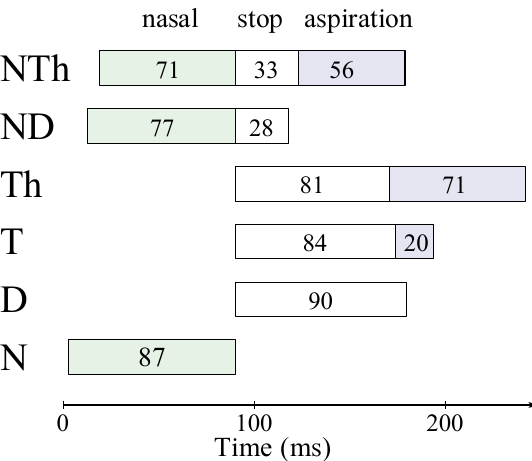
Figure 6: Results of duration measurements: green = nasal stops, white = oral stops, lavender = aspiration